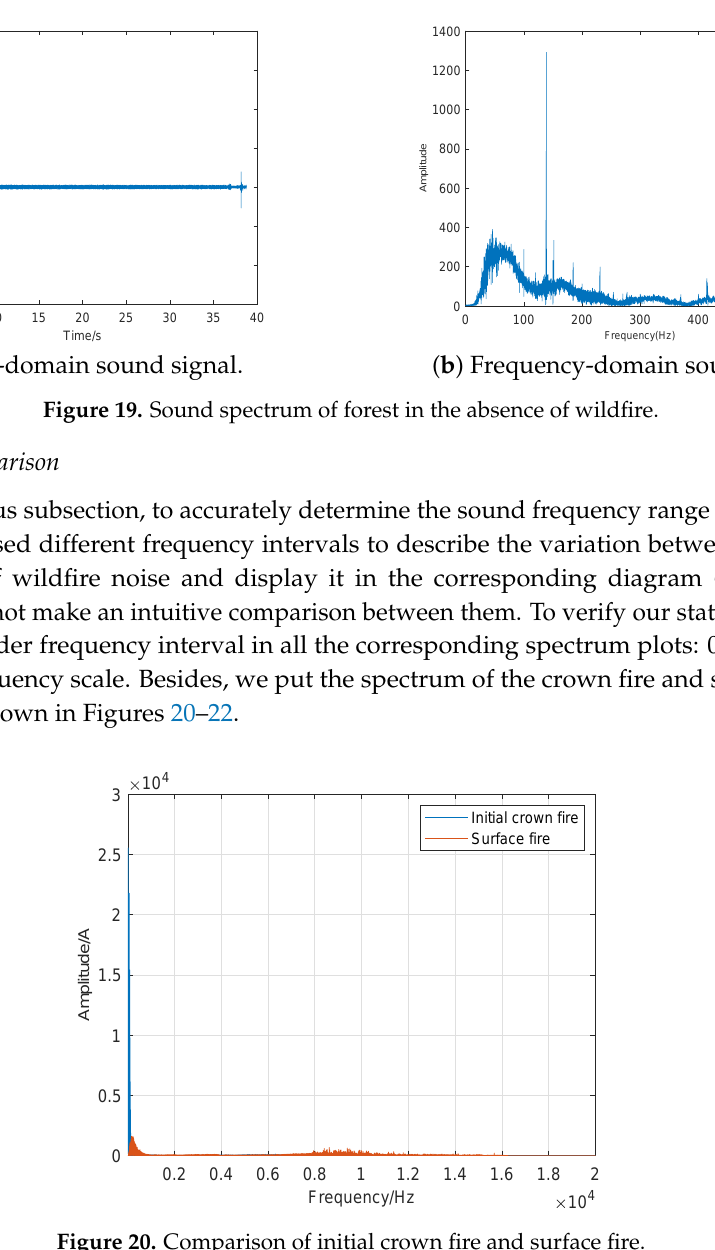
Figure 20. Comparison of initial crown fire and surface